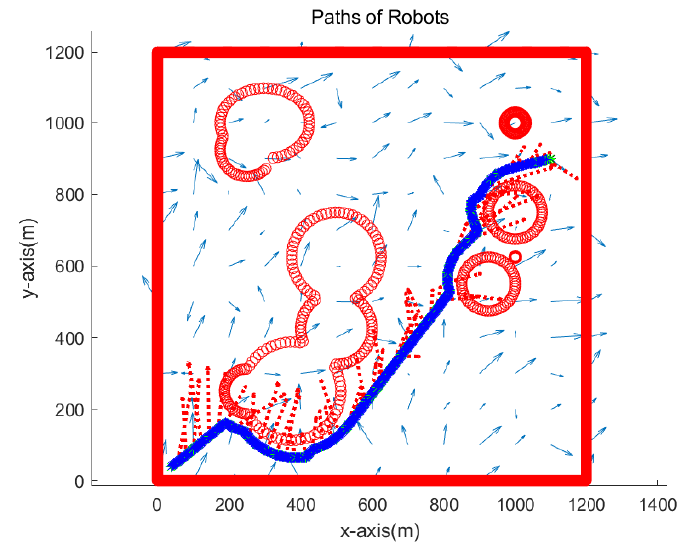
Figure 13. Scenario 3. In Scenario 3, the perturbation vector field was generated by adding Gaussian noise with zero mean and standard deviation of 0.05 to the noiseless perturbation vector. The path of one robot is depicted with blue asterisks, and that of another robot is depicted with green asterisks. See that two robots approach the goal while avoiding obstacles.